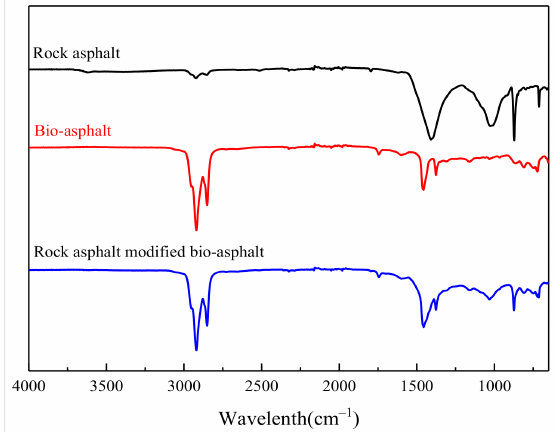
Figure 18. Infrared spectroscopy of rock asphalt, bio-asphalt and rock asphalt-modified bio-asphalt.